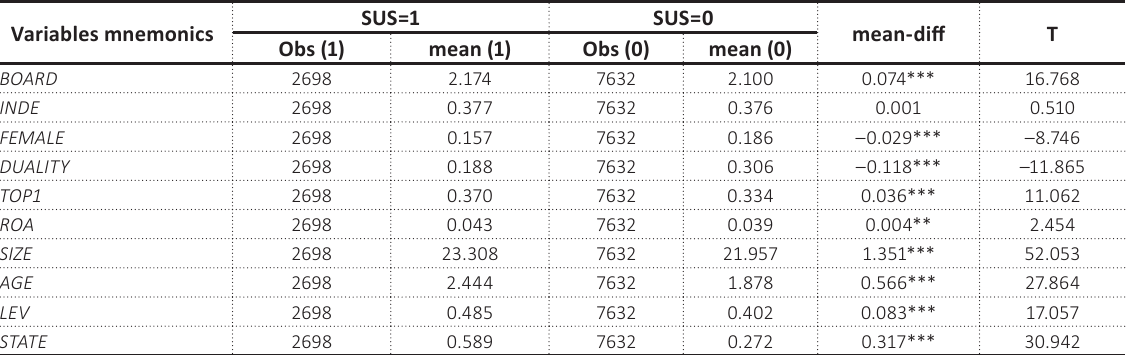
Table 7. T -test results on sustainability reporting conduct